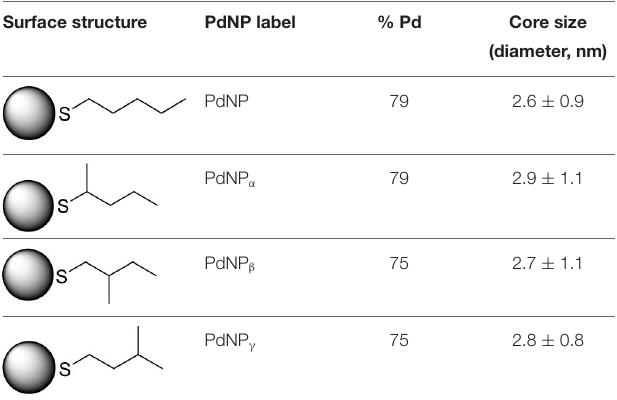
TABLE 1 | % Pd and average core size of four synthesized palladium